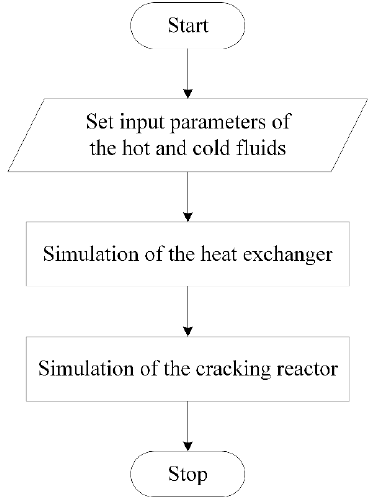
Figure 6. Simulation of one reforming unit.